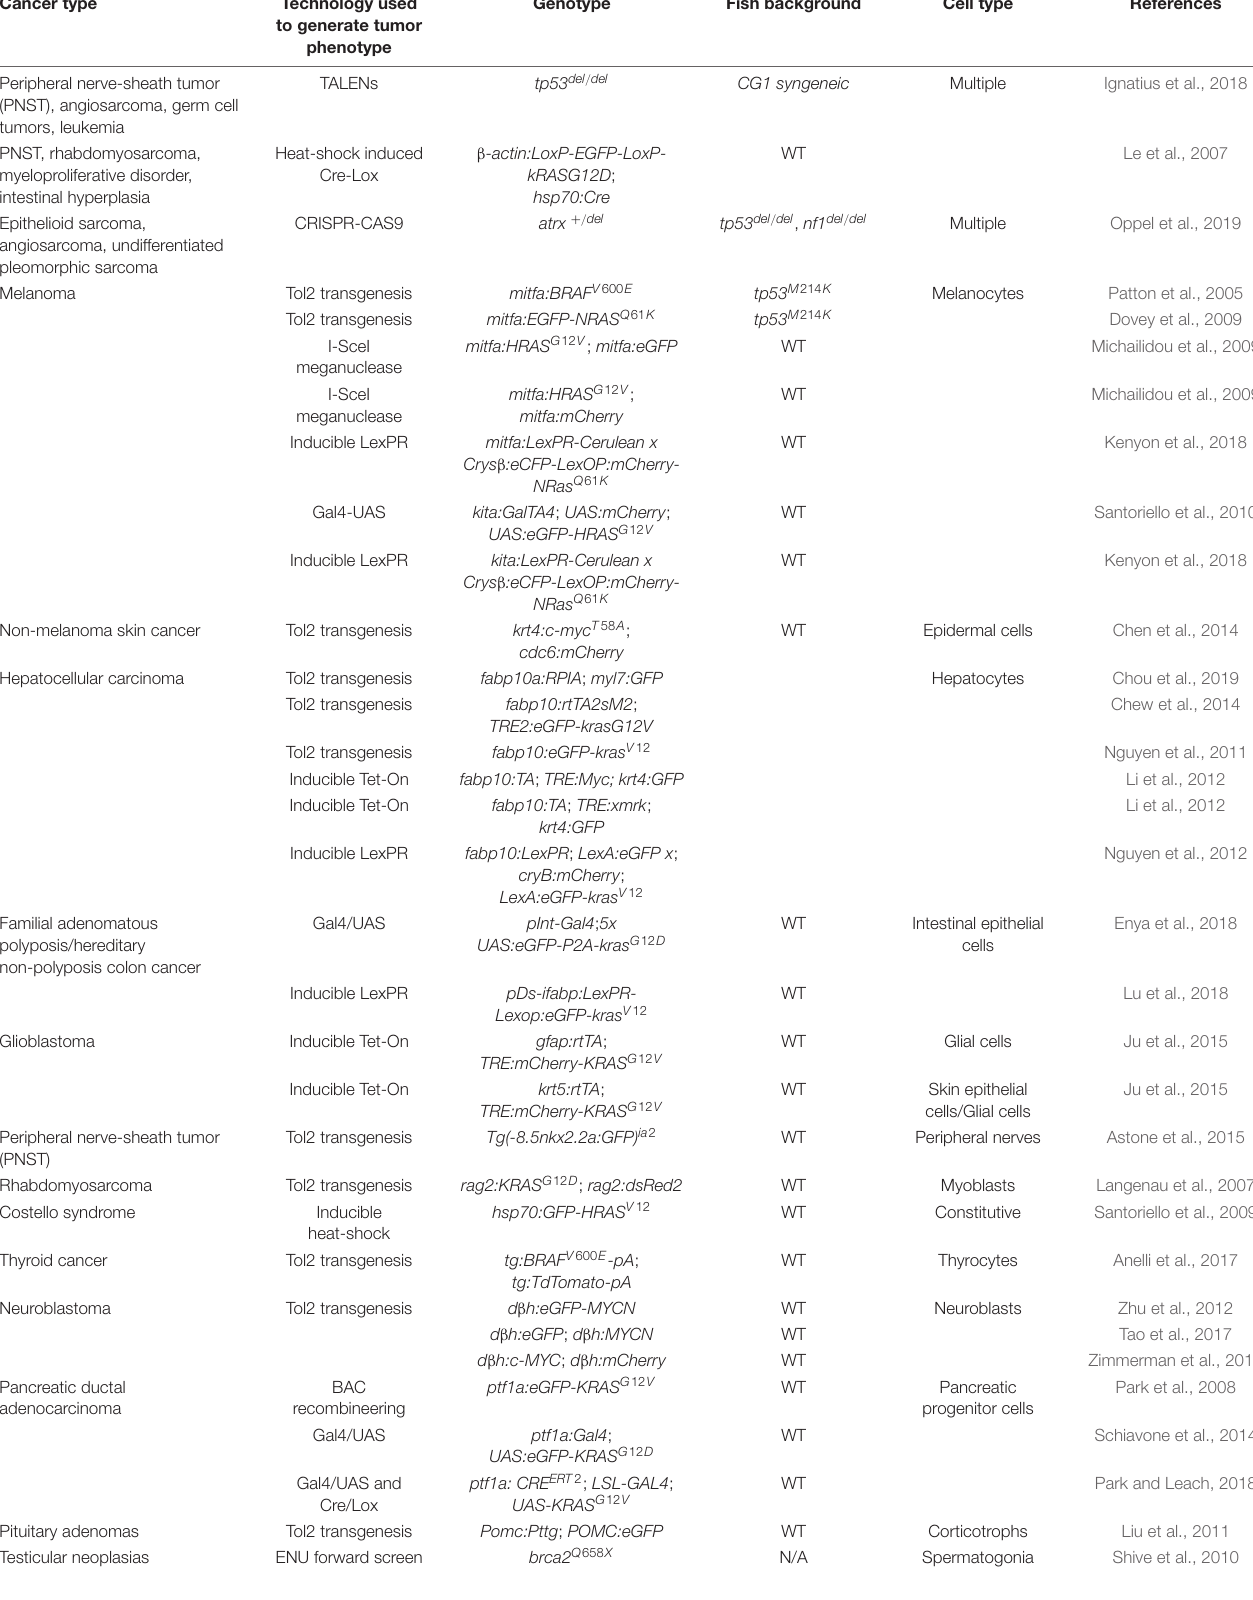
TABLE 4 | Zebrafish cancer